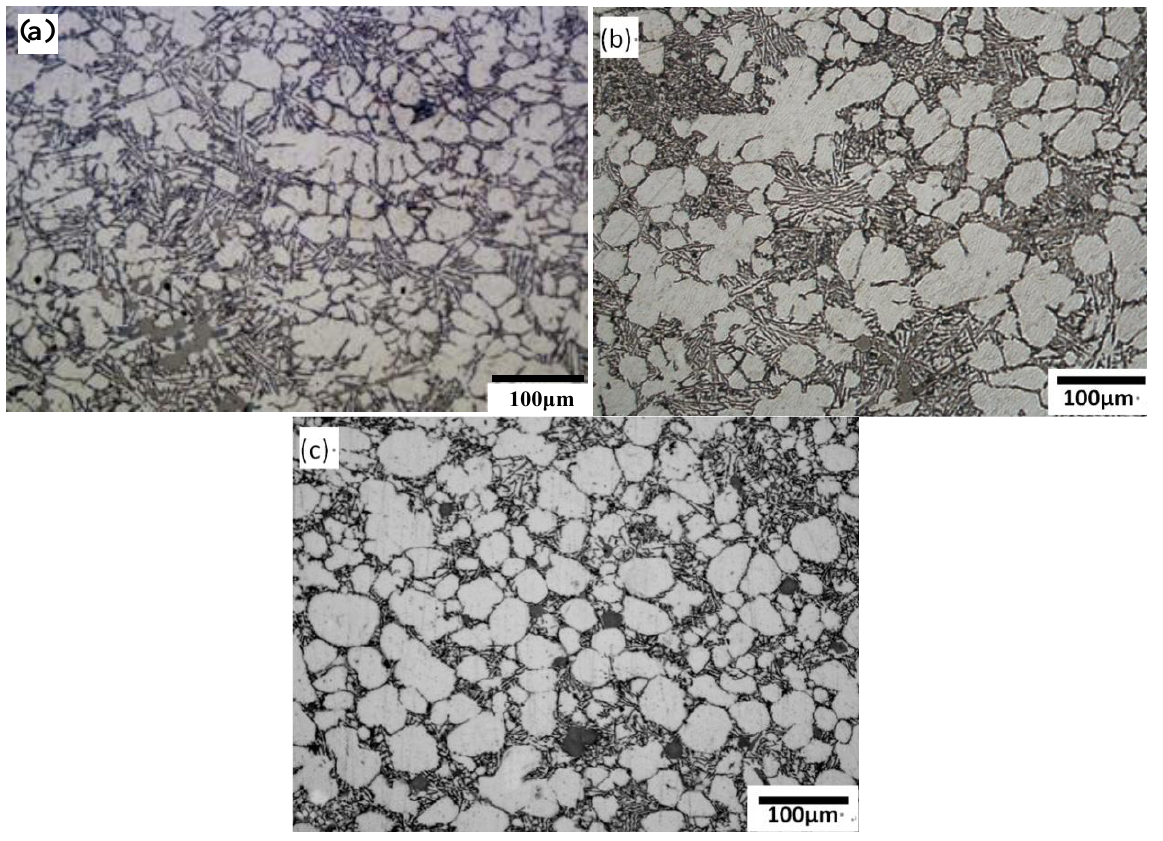
Figure 5. Optical micrographs of semisolid A380 alloy under different barrel temperature